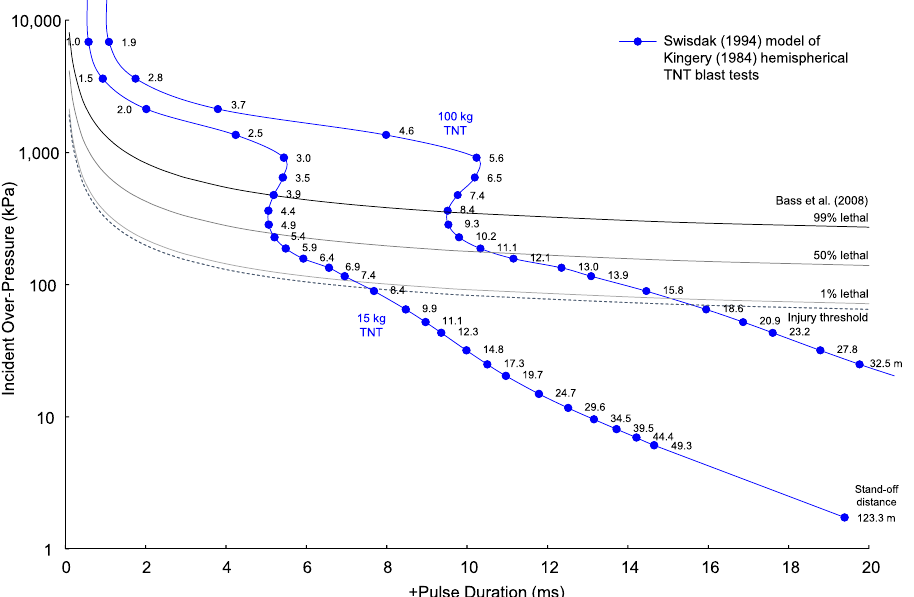
Figure 13. Injury and fatality risks with stand-off distance from incident shock waves.